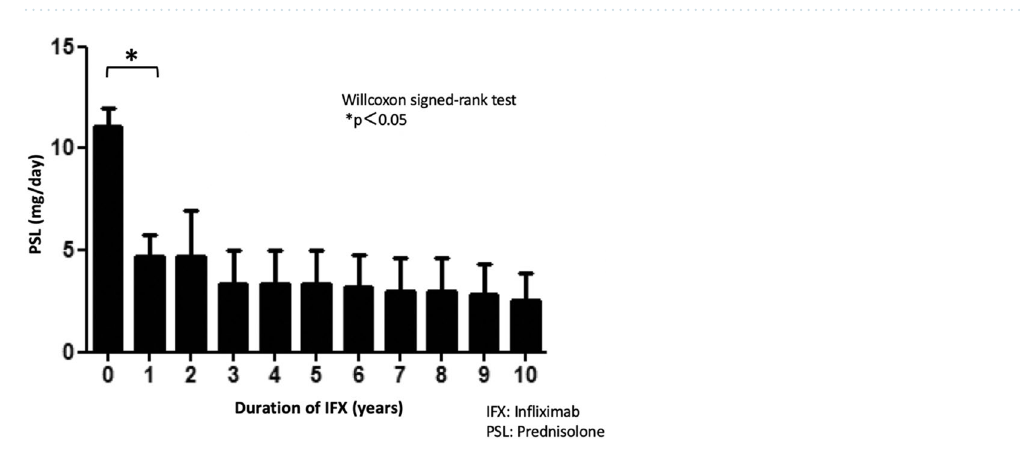
Figure 4. Corticosteroid (CS)-sparing effect. The analysis of the 10-year CS-sparing effect demonstrated that the steroid-sparing effect reached -8.6 mg/day (11.1 mg/day to 2.5 mg/day: 77.5%). There were 2 patients that were able to withdraw from CS during this